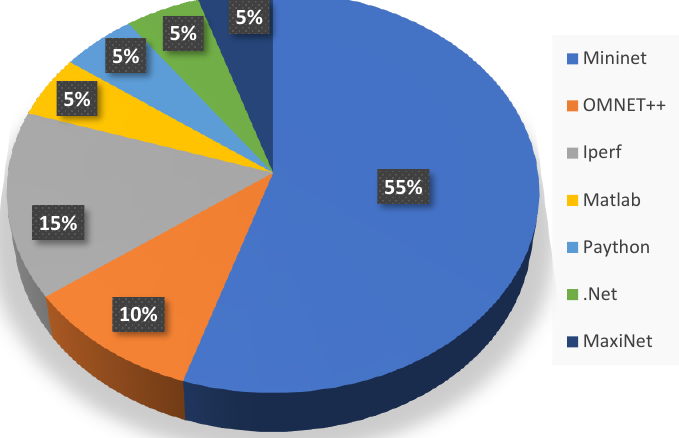
Figure 7. Distribution of the selected articles by the mathematical tool/emulator adopted as shown in Table